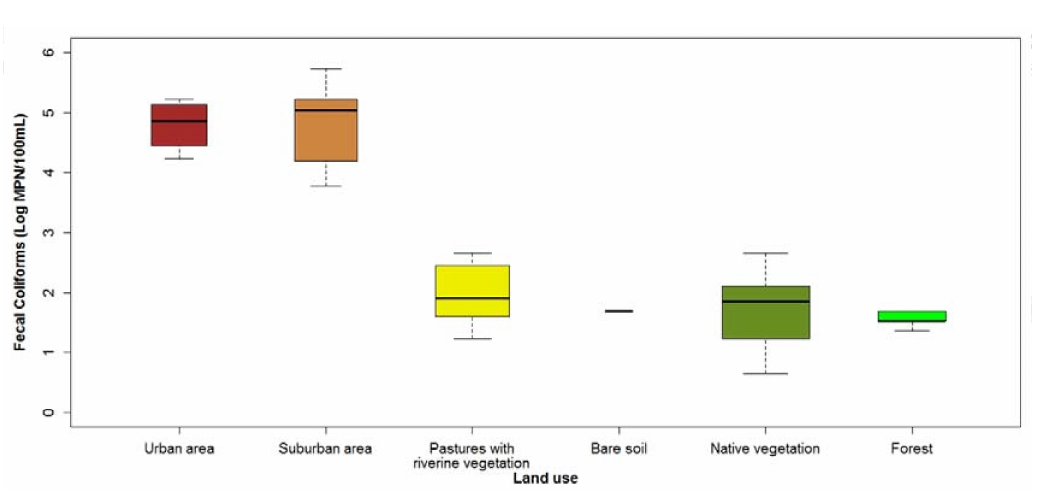
Figure 3. Boxplots of the fecal coliforms variation according to land